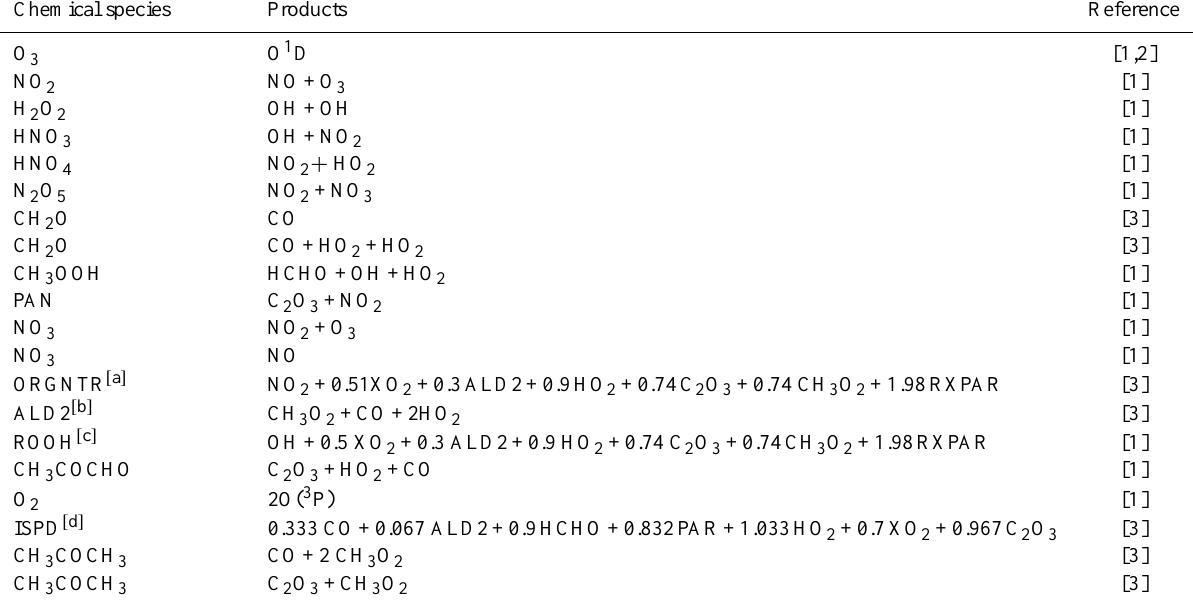
Table A2. The photolytic reaction rates included in the modified CB05 chemical mechanism. The reaction products O 2 and H 2 O are not shown. The stiochiometery of each photolytic reaction is taken from Yarwood et al. (2005) except for the photolysis of O 2 . The source of the absorption co-efficients and quantum yields are thus: [1] Sander et al. (2011), [2] Matsumi et al. (2002), [3] Atkinson et al. (2006). Further details: [ a ] absorption cross section for a C4 mono-nitrate are adopted (Roberts and Fayer, 1989), [ b ] the absorption cross section for CH 3 CHO is adopted, [ c ] set equal to the photolysis frequency of CH 3 OOH due a lack of laboratory measurements and [ d ] the absorption cross sections are set equal to an average of methyl vinyl ketone and